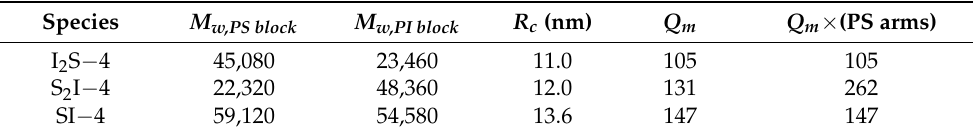
Table 2. The molecular characteristics and the SAXS results for the mirror-like I 2 S and S 2 I copolymers, as well as their linear counterpart, SI − 4. Species M w,PS block M w,PI block R c (nm) Q m Q m × (PS arms) I 2 S −